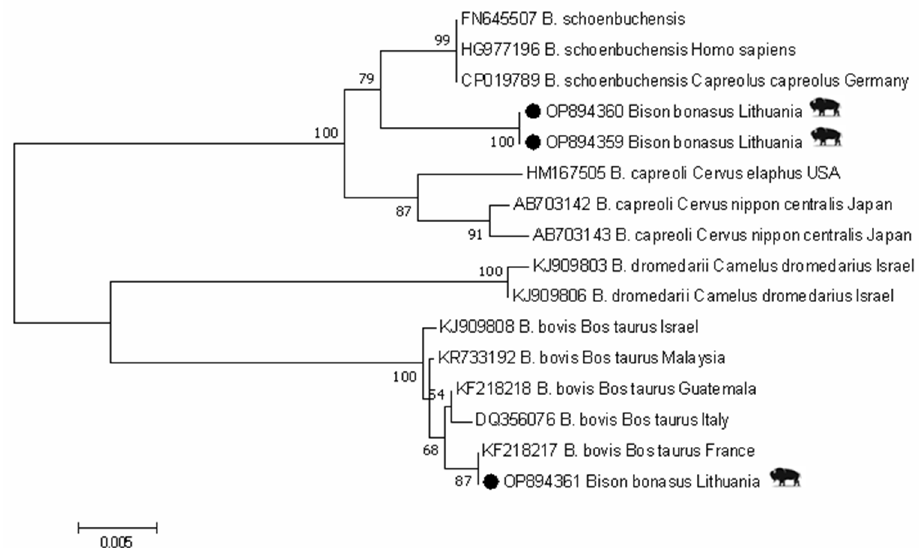
Figure 3. Phylogenetic tree of Bartonella spp. using rpoB gene sequences constructed by Maximum Likelihood method and Tamura–3 parameter model. Numbers on the tree indicate bootstrap support (values < 50% not shown). The identification source (host) and country are given after the accession numbers. Bartonella sample in this study isolated from European bison is marked with ● .